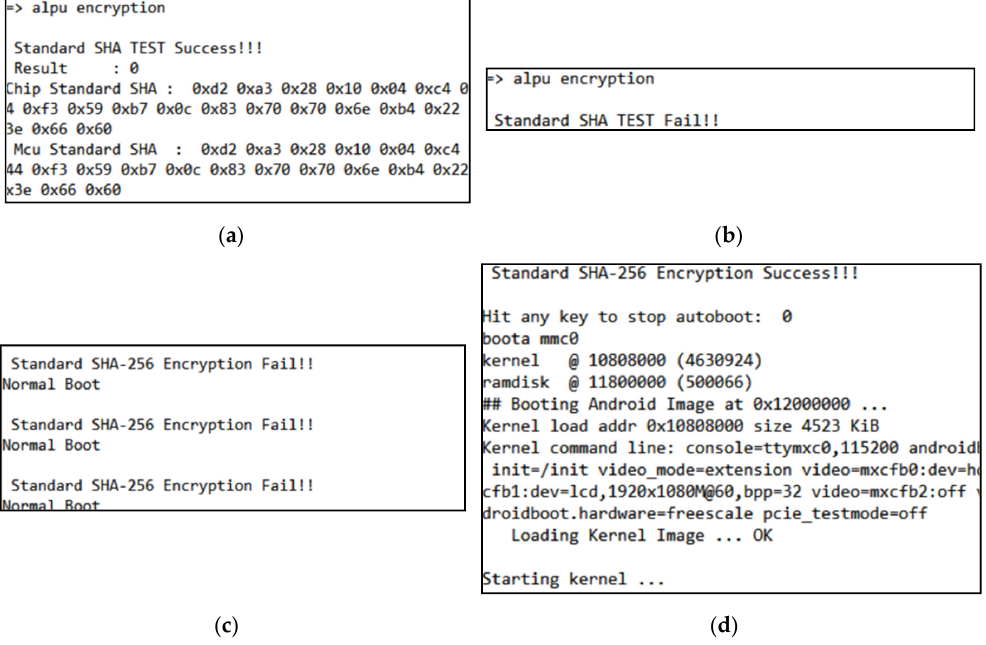
Figure 6. Demonstration of the booting process policies: ( a ) With ALPU; ( b ) Without ALPU; ( c ) ALPU with different key value; ( d ) ALPU with the same key value.